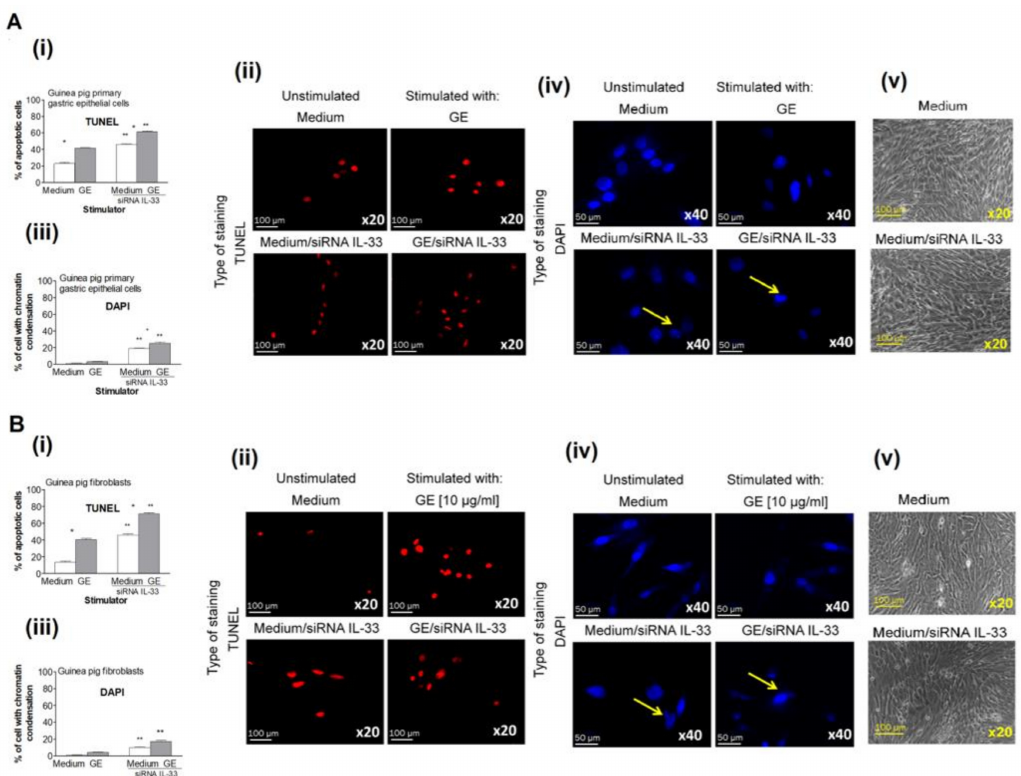
Figure 5. Assessment of apoptosis by terminal deoxynucleotidyl transferase (TdT)-mediated dUTP nick end labeling (TUNEL) assay and 4 (cid:48) ,6-diamino-2-phenylindole (DAPI) nuclear staining. Results for the guinea pig primary gastric epithelial cells ( A ) or fibroblasts ( B ), untransfected or transfected with siRNA, in medium only or exposed to H. pylori glycin acid extract) (GE)presented as the percentage of apoptotic cells stained in the TUNEL assay and counted using the Image J software version 1.48v (National Institute of Health, United States) ( i ). ( ii ) Representative images of cells stained in the TUNEL assay (red nuclei) and photographed in the fluorescence microscope (Axio Scope A1, Zeiss, Germany) at wavelengths: 550 nm (excitation) and 590 nm (emission), at magnification x20. ( iii ) The percentage of cells stained with DAPI, indicating the chromatin condensation. ( iv ) Representative images of cells stained with DAPI (blue nuclei) and photographed in the fluorescence microscope (Axio Scope A1, Zeiss, Germany) at wavelengths: 345 (excitation) and 455 nm (emission), at magnification × 40. ( v ) Representative images of untransfected cells cultured in medium only (medium) or transfected with siRNA IL-33 and cultured in medium only (medium / siRNA IL-33) photographed in the phase-contrast microscope (YS100 Nikon, Tokyo, Japan), at magnification × 20. The results of four independent experiments performed in triplicates for each experimental variant are presented. Statistical analysis was performed using the nonparametric U Mann-Whitney test with significance for *, ** p < 0.05, * unstimulated (only medium) vs. GE stimulated, untransfected or tranfected cells, ** untransfected vs. transfected cells, in medium only or in medium with